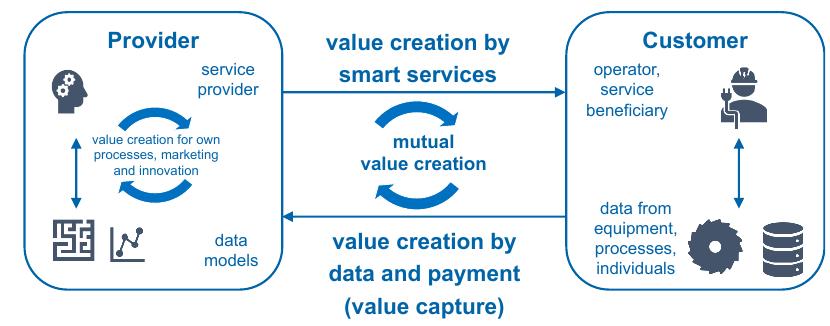
Fig. 2. Mutual value creation model in the dyadic provider – customer model (adapted from